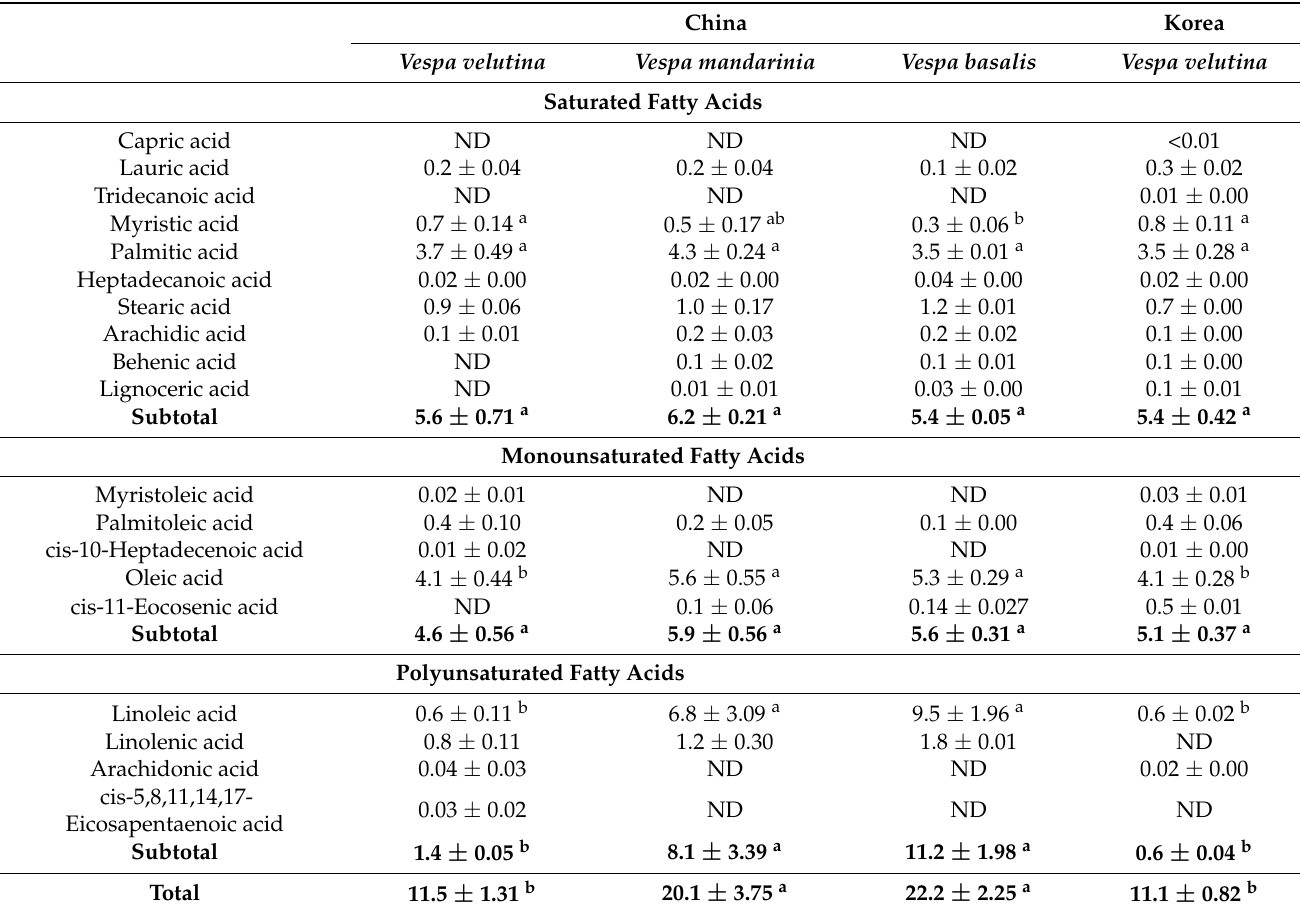
Table 2. Fatty acid composition (g/100 g dry matter, mean ± SD, duplicate analysis with composite sampling process) of different Vespa species broods. Superscripts indicate a significant difference ( p ≤ 0.05) for selected predominating fatty